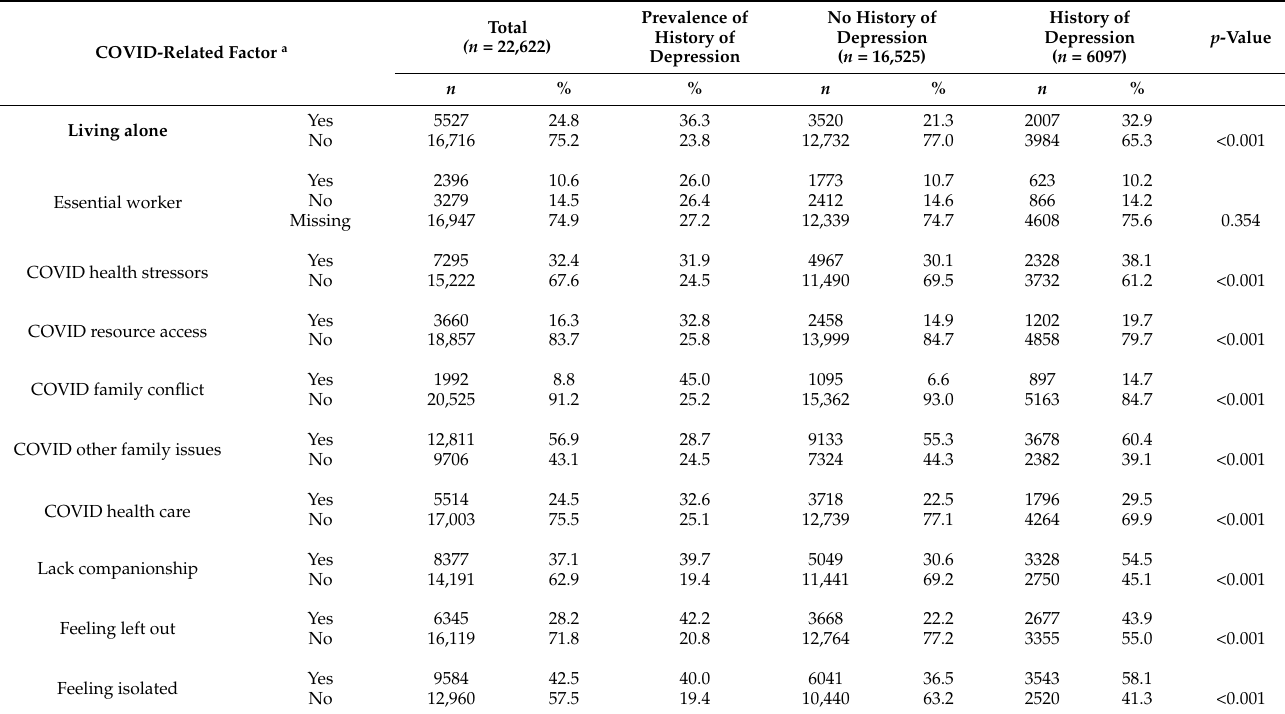
Table 2. History of depression across COVID-related